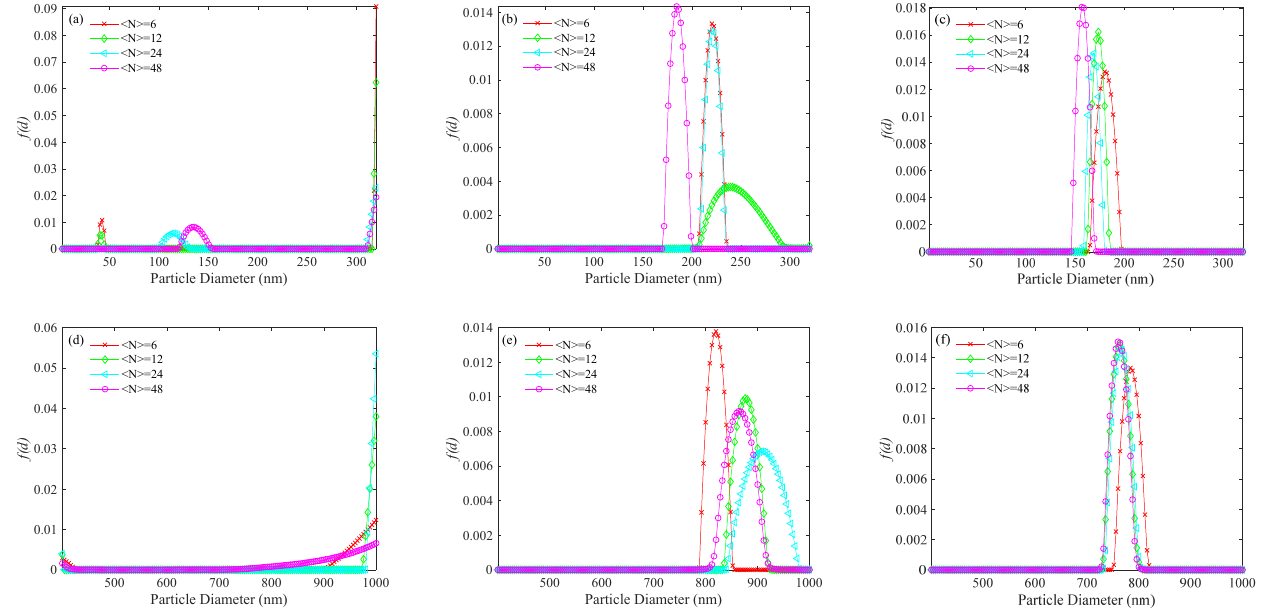
Figure 10. PSDs recovered for standard polystyrene latex spheres at number concentrations of < N > = 6, 12, 24, 48: 152 nm diameter sample; ( a ) the usual method, ( b ) the KFR method, and ( c ) the BR method; and the PSDs recovered for the 693 nm diameter sample; ( d ) the usual method, ( e ) the KFR method, and ( f ) the BR method. Table 5. Performance indices for the recovery of 152 and 693 nm